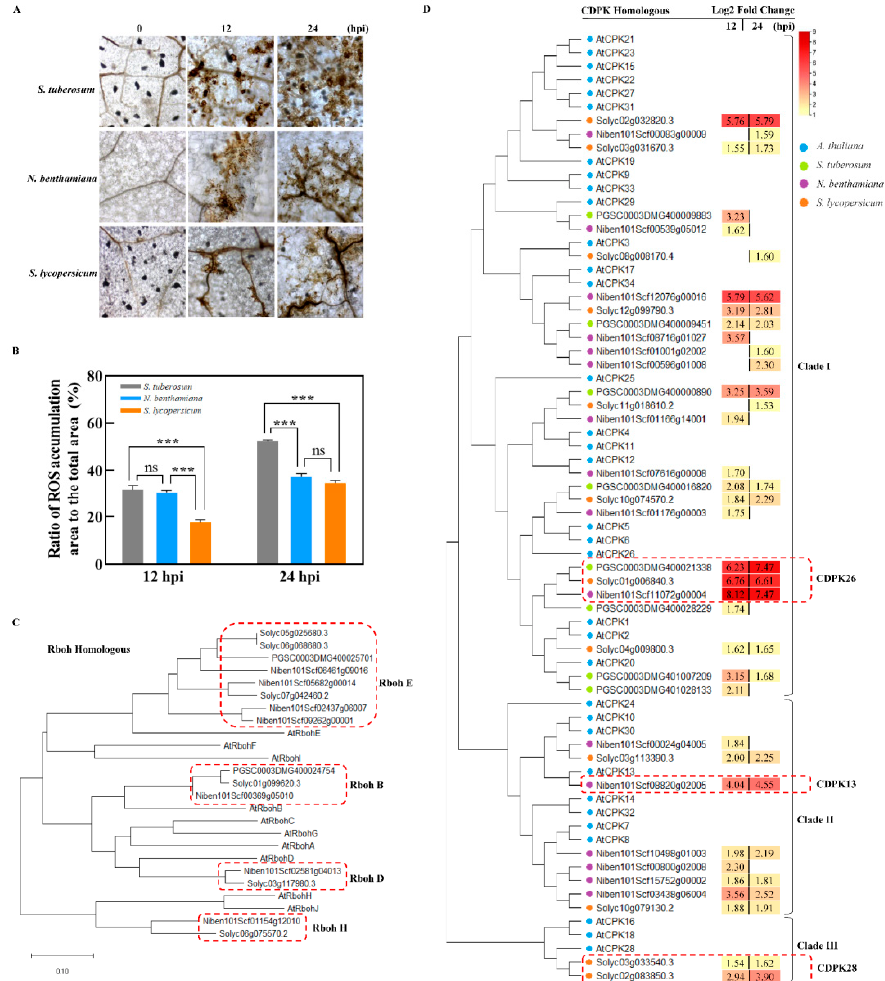
Figure 6. Comprehension analysis of ROS accumulation among the TSHs at 0, 12 and 24 hpi infected by P. infestans . ( A ) Phenotype of P. infestans -induced ROS accumulation among TSHs. DAB staining for detection ROS burst was performed at 0, 12 and 24 hpi. The dark yellow flecks represented the ROS accumulation sites. Twenty leaves were collected for statistical analysis. ( B ) Quantitative statistics of ROS accumulation ratio to the total area in TSHs at 0, 12 and 24 hpi. Data represent means and standard errors of three biological replicates (ns, p > 0.05; ***, p < 0.001, one-way ANOVA). ( C ) Phylogenetic tree of respiratory burst oxidase homolog (RBOH) family genes in A. thaliana and TSHs. ( D ) Phylogenetic tree of CDPK homologous genes in A. thaliana and TSHs. Up-regulated genes were selected in transcriptome data used for phylogenetic trees. The rectangle with number represented log2 fold change of CDPK genes in TSHs at 12 and 24 hpi. The blue, green, purple and orange dots represent A. thaliana , S. tuberosum , N. benthamiana and S. lycopersicum, respectively. The red dotted line boxes indicated to belong the homolog genes, such as Rboh E , Rboh B , Rboh D and CDPK26